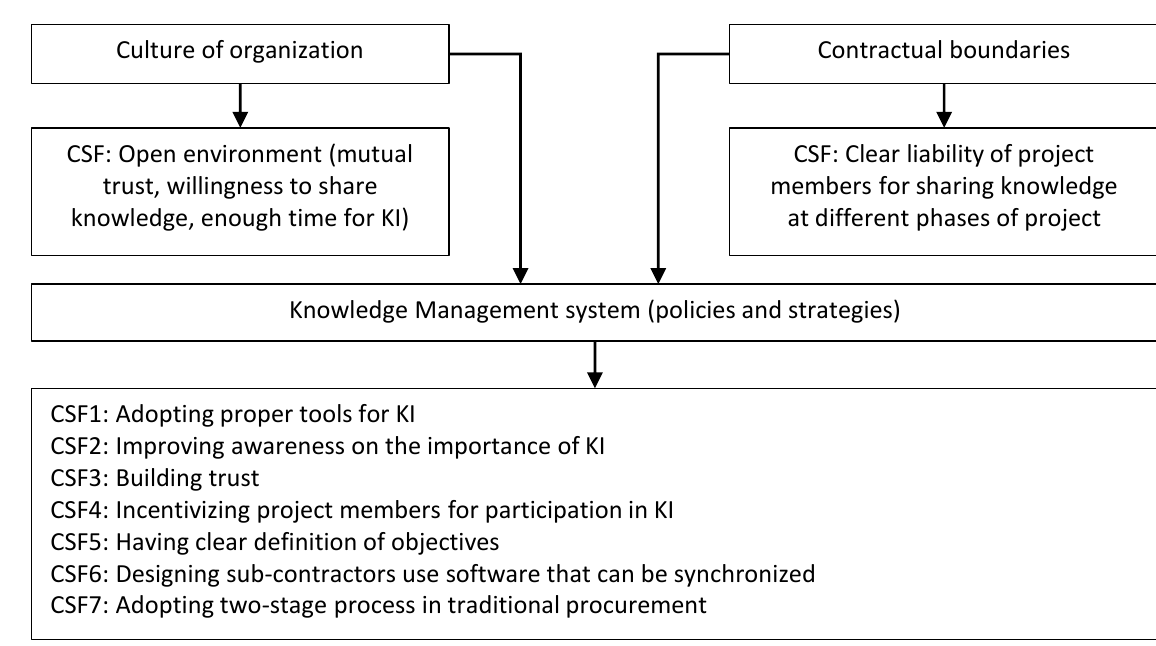
Figure 3. KI challenges and its CSFs within the